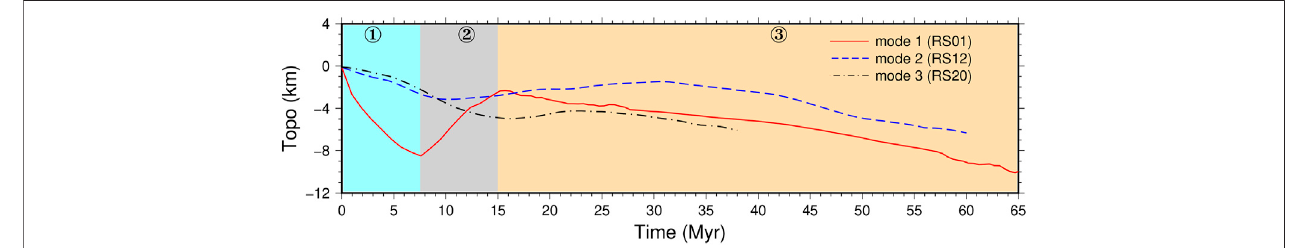
FIGURE 5 | Time evolution of the topography on the overriding continental plate for case RS01 (the fast spreading mode), case RS12 (the slow spreading mode) and case RS20 (the extinction mode). Three different background colors show the three stages for case RS01 of the fast spreading mode. Stage 1 is0 – 7.5 Myrs, when the foregoing oceanic plate subducts into the mantle; stage 2 is 7.5 – 14 Myrs, when the MOR subducts; stage 3 is 14 – 65 Myrs, when the following oceanic plate subducts into the mantle.